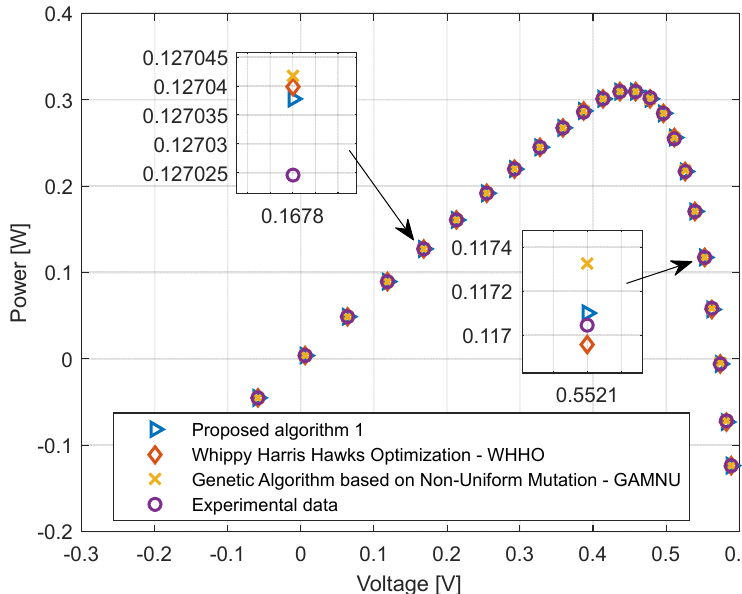
Figure 6. Power-voltage characteristics of the RTC France solar cell.